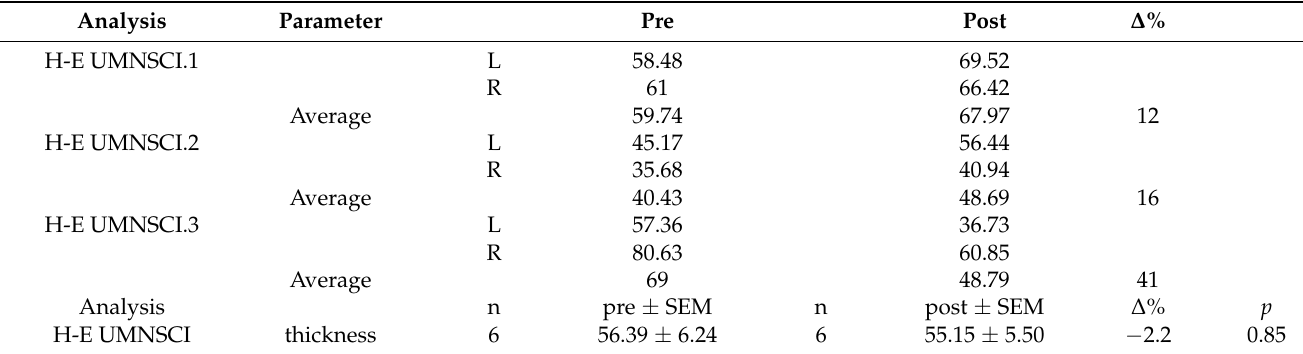
Table 3. Epidermis thickness ( µ m): UMNSCI pre and post